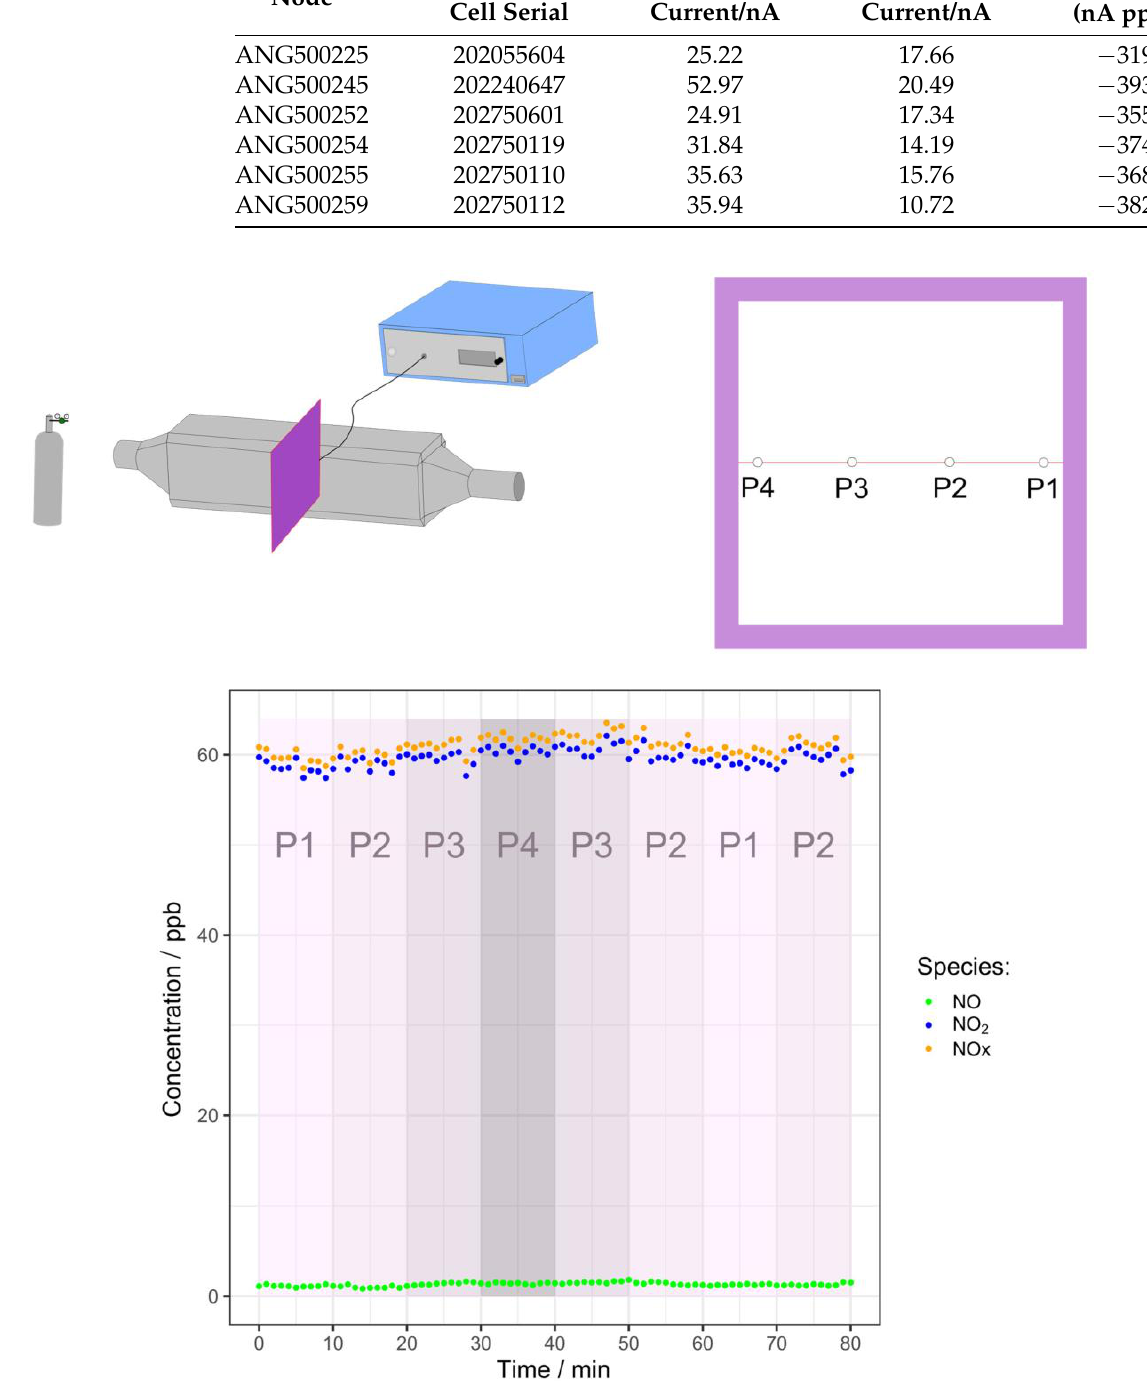
Figure A3. Results of mixing test in EASE duct, the sampling line was moved between points P1 and P4 shown in the schematic ( above ) at the realtive times shown in the plot ( below ). As can be seen from the plot there was not a significant difference in NO 2 either for the different points or the same points at different times. The small fluctuations in concentration over time are caused by slight fluctuations in total flow through the